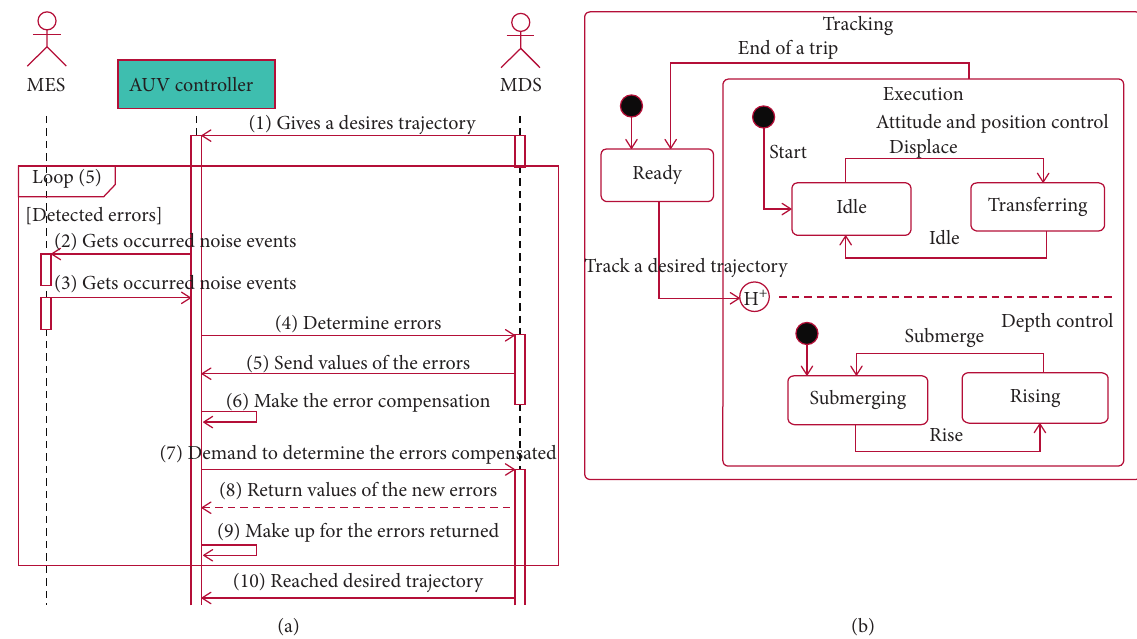
Figure 3: A desired trajectory-tracking scenario (a) and local state machine for performing the “track a desired trajectory” use case (b).